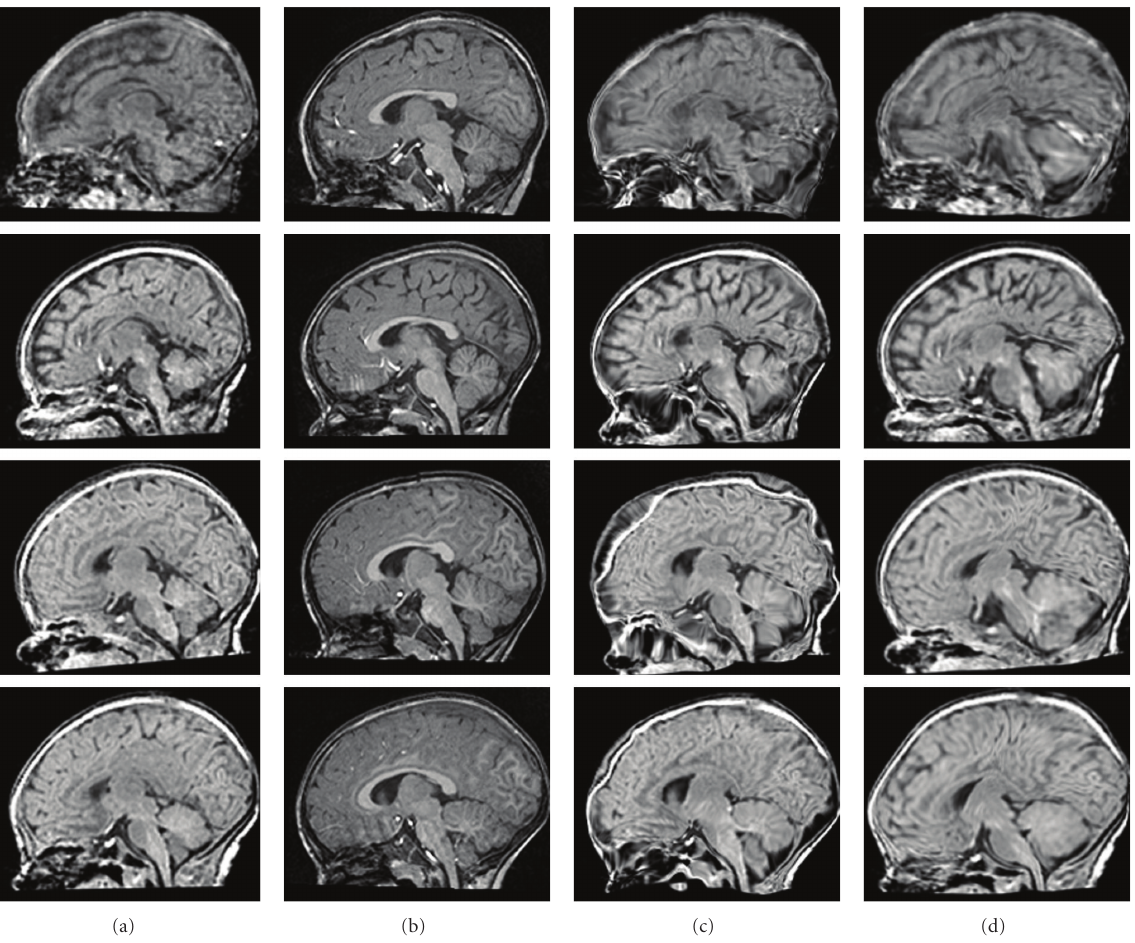
Figure 11: Registration results of neonates mapped to 2-year olds. From left to right: (a) neonatal T1 image after a ffi ne registration, (b) reference T1 image at 2 years, followed by (c) neonatal T1 after deformable mutual information registration using B-splines, and (d) after combined probabilistic and geometric registration. From top to bottom 0156, 0174, 0177, and